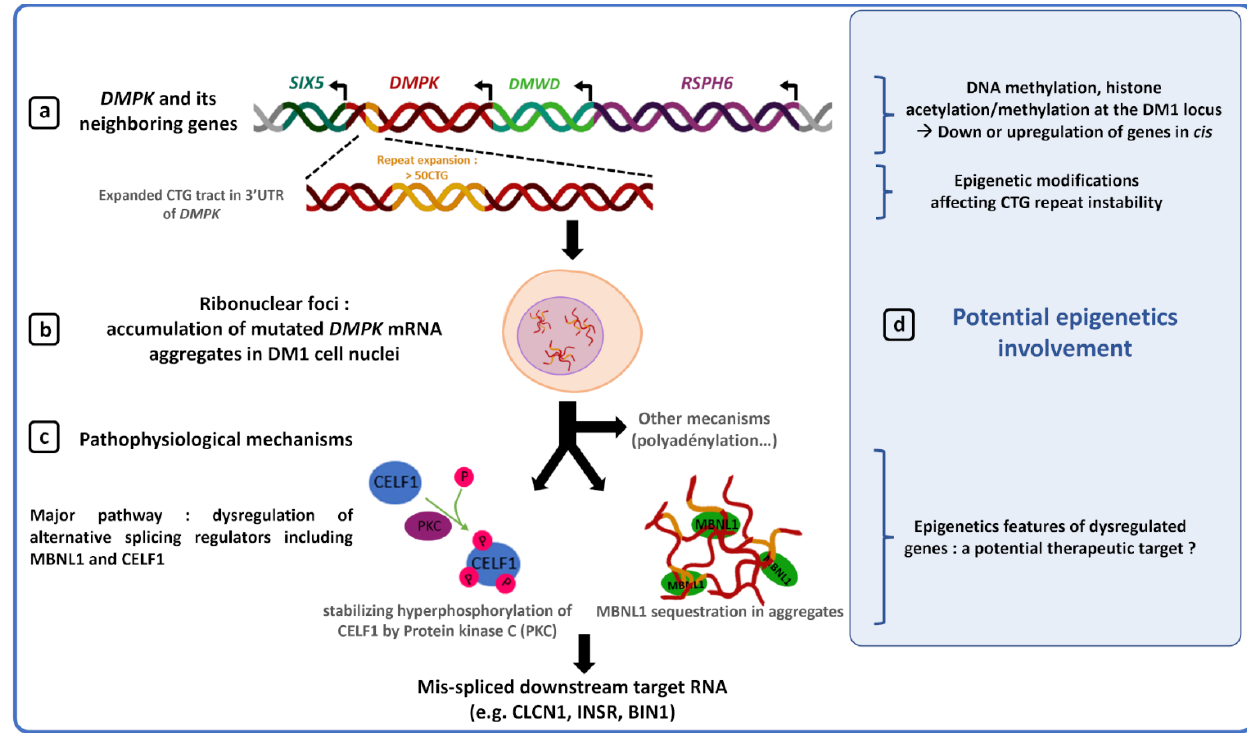
Figure 2. Molecular pathogenesis of DM1. ( a ) DM1 locus [49–53]. ( b ) Mutated mRNAs aggregation forms toxic ribonuclear foci [60]. ( c ) DM1 physio-pathological mechanisms [60–63]. ( d ) Epigenetics involvement and potential therapeutic targets in DM1 disease.